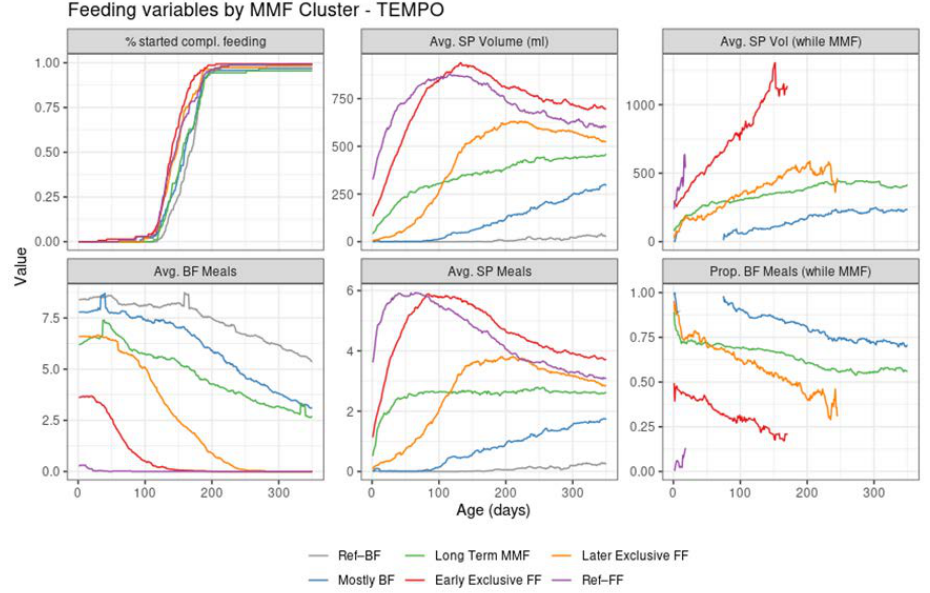
Figure 3. Summary of feeding variables in TEMPO per cluster from birth (leftmost) to 350 days of age (rightmost). First row: % started compl. feeding—percentage of subjects introduced to complementary feeding; Avg. SP Volume (mL)—average of the estimated daily study product volume intake across all subjects in the cluster; Avg. SP Vol (while MMF)—average of the estimated study product volume intake in ml per day, across the subjects in the cluster who are mixed feeding at that time point. Second row: Avg. BF Meals—average of the estimated daily number of daily BF meals; Avg. SP Meals—average of the estimated daily number of daily study product meals; Prop. BF Meals (while MMF)—proportion of BF meals from the total of BF meals and study product